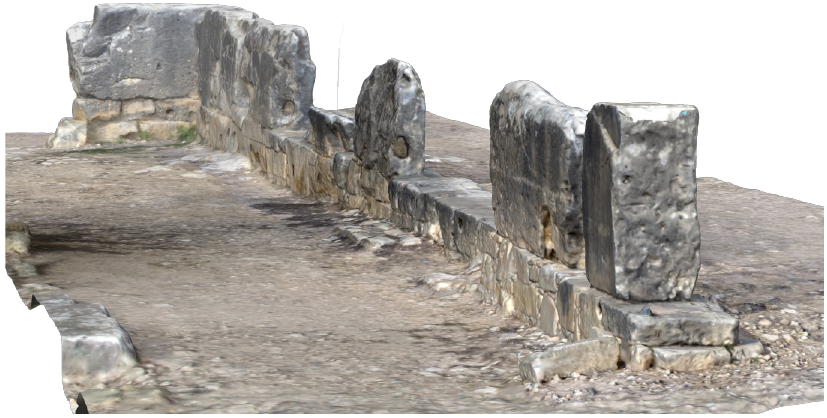
Figure 2. Sanctuary I: the surviving LC temenos megaliths (internal view). 3D by V. Tringas